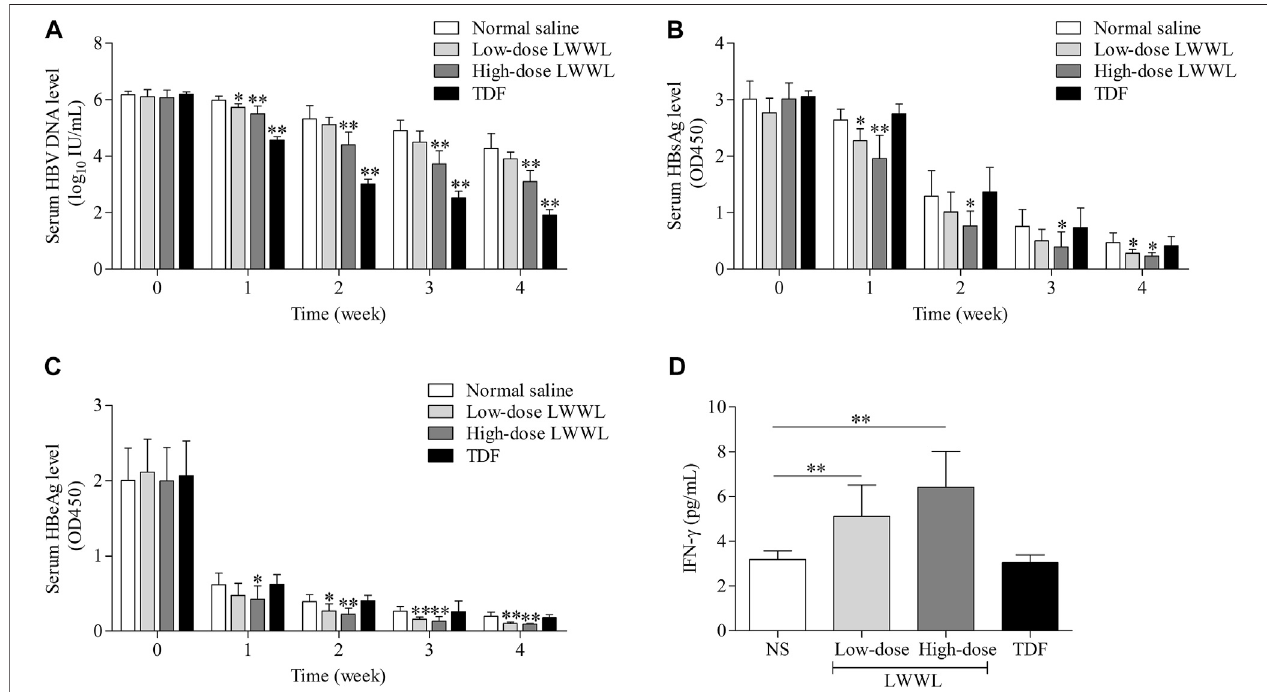
FIGURE3| TheimpactsofLWWLonHBVDNA/antigenandIFN- γ ofpAAV-HBV1.2replicationmice.TheimpactsofLWWLandTDFonserum (A) HBVDNAlevel, (B) HBsAg level, and (C) HBeAg level. (D) The impact of LWWL and TDF on serum IFN- γ level. * and ** represent p < 0.05 and p < 0.01 respectively in difference comparison betweenresultant values treatedwitheach indicatedconcentrationofLWWLorTDF andthevaluetreatedwithNS.NS,normalsaline; LWWL,Liuweiwuling Tablet; TDF, tenofovir disoproxil fumarate; interferon- γ , IFN- γ .